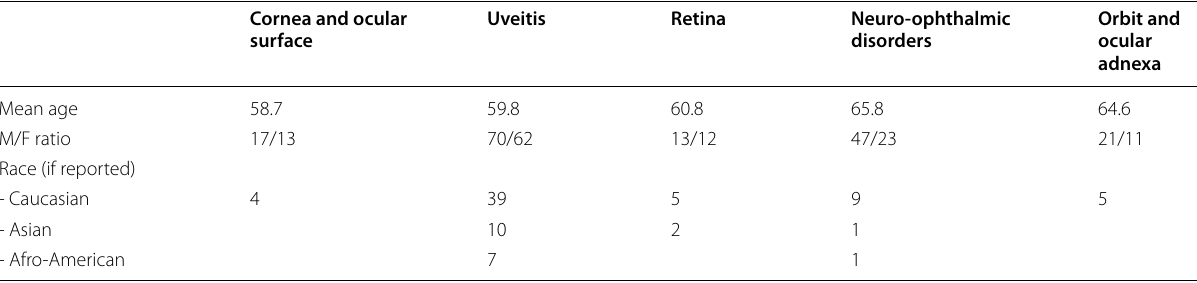
Table 3 Demographic